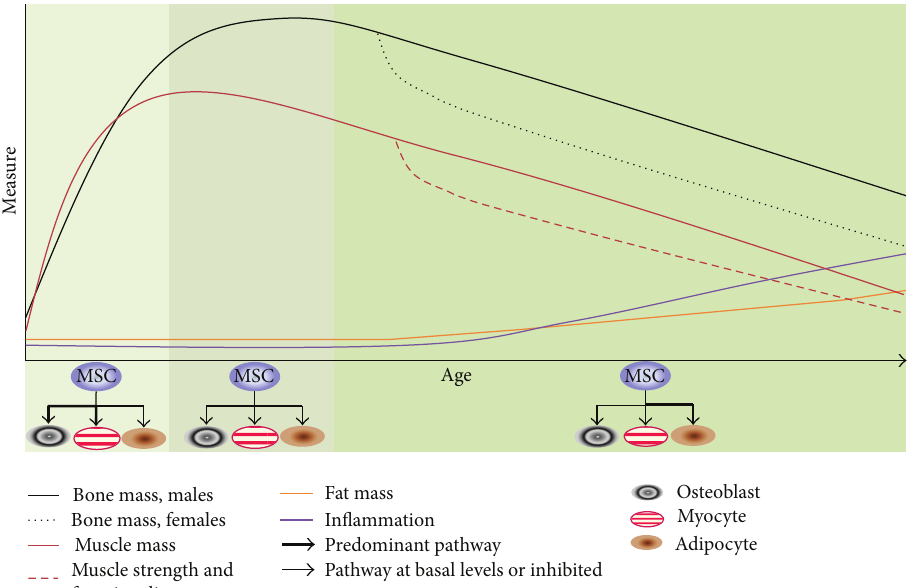
Figure 1: Age-related changes in bone, muscle, and fat tissues and related